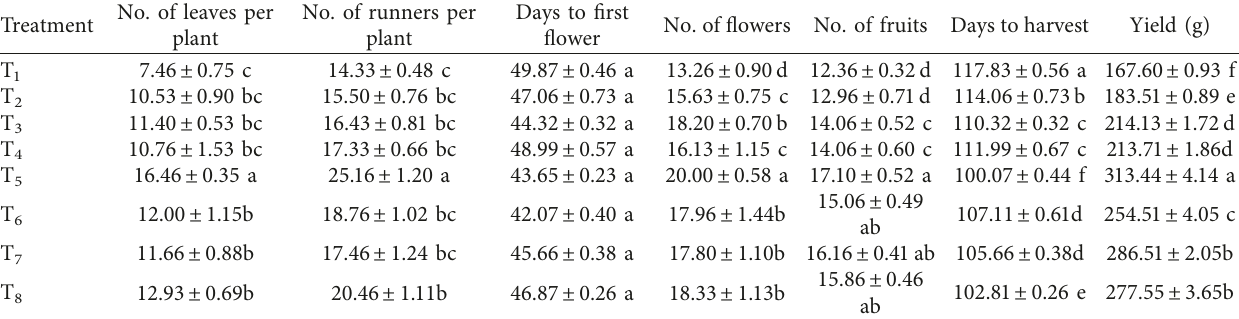
Table 2: Influence of different organic and inorganic fertilizer regimes on vegetative and reproductive growth of strawberry cv. Chandler. No. of leaves per No. of runners per Days to first Treatment No. of flowers No. of fruits Days to harvest plant plant flower